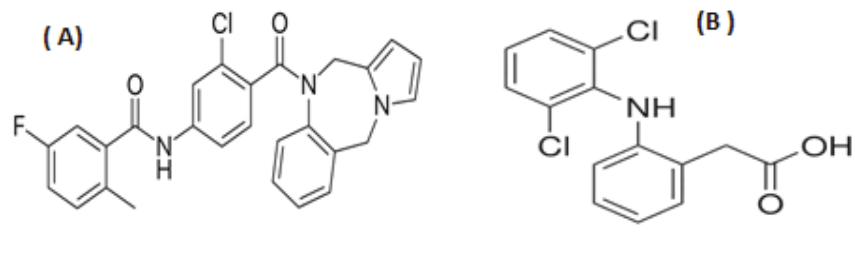
Figure 1: Chemical structure of: (A) lixivaptan and (B) the internal standard (IS) diclofenac